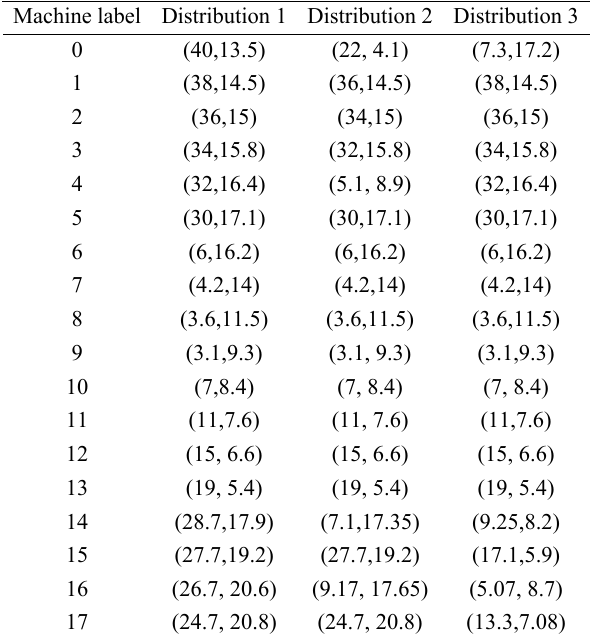
Table 4 Three machine distributions’ information.